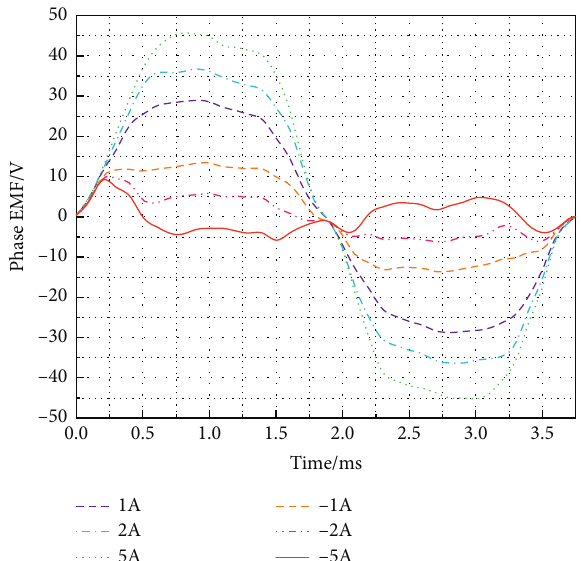
Figure 16: EMF of the PMCHEG with PM and electric excitation